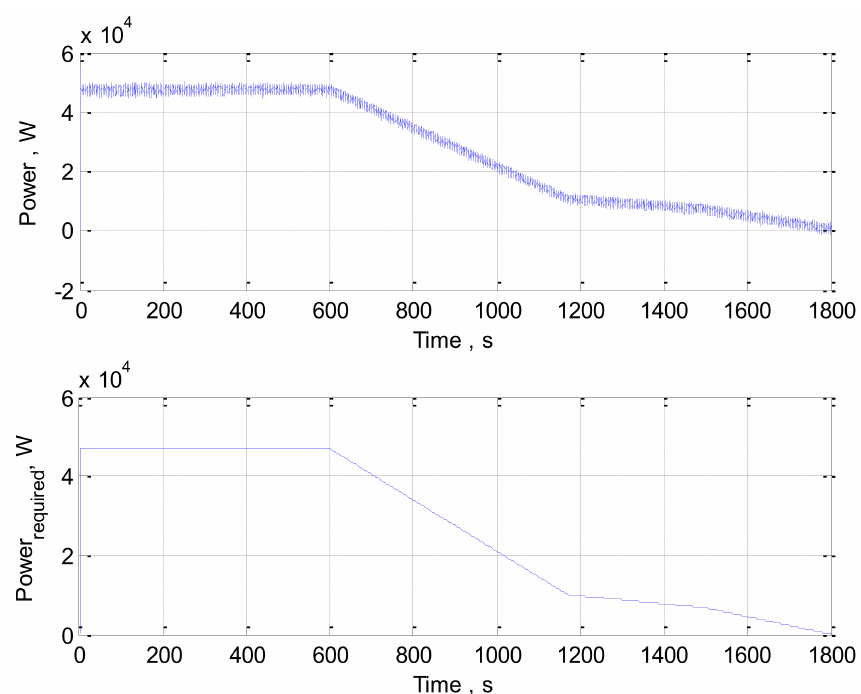
Figure 8. Realized and reference power at C = 500 F.